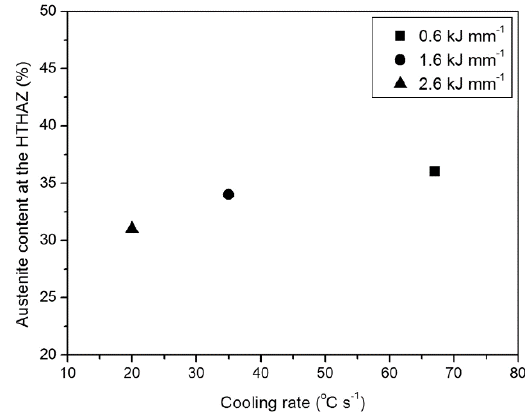
Figure 15. Austenite content versus locally calculated cooling rates at the HTHAZ.